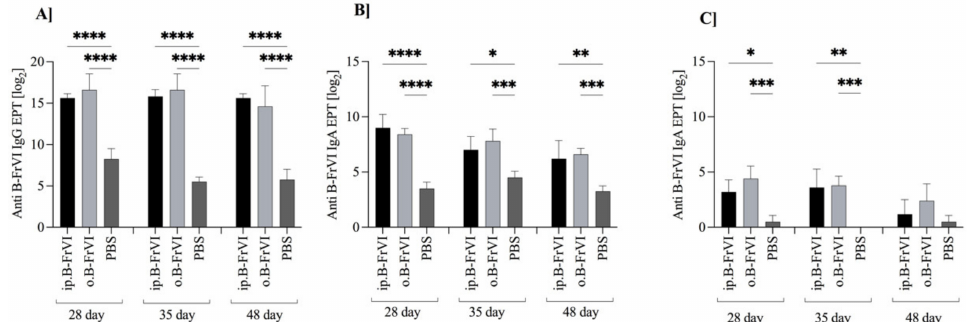
Figure 4. The humoral immune response of Balb/c mice to barley fraction VI (B–FrVI) to: ( A ) specific serum IgG; ( B ) specific serum IgA; and ( C ) specific IgA in fecal extracts. Mice were divided into three groups: sensitized (ip.B–FrVI, black bars), gavaged with antigen (o.B–FrVI, light grey bars), and PBS treated as control (PBS, dark grey bars). Data are expressed as the mean ± SD from the group (n = 6). Two-way ANOVA performed the statistical analysis. Statistical differences were assigned * for p < 0.05; ** for p < 0.01; *** for p < 0.001; and **** for p <